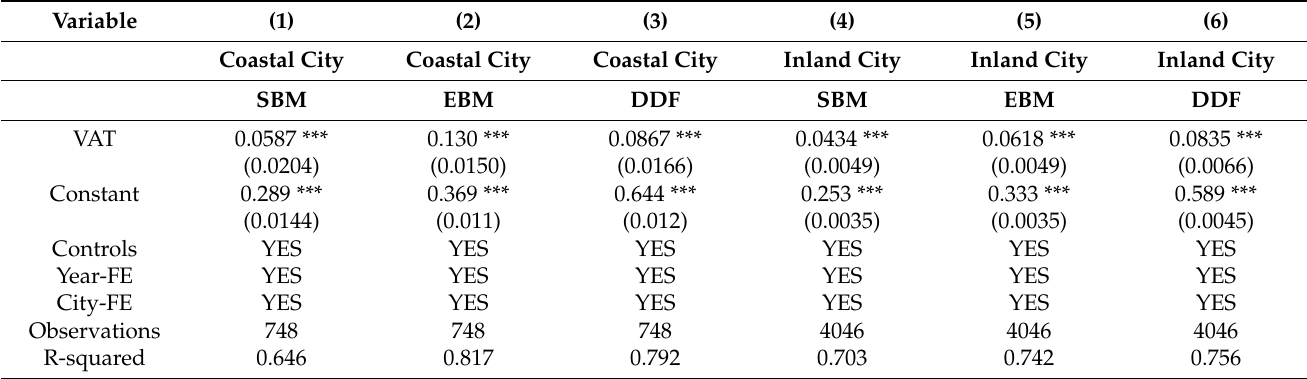
Table 7. Heterogeneity test: Coastal and Inland